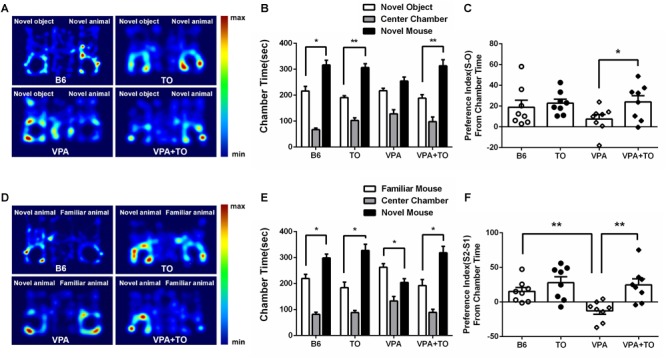
TO pretreatment improved sociability and novel recognition of VPA-exposed mice. (A) Representative heat maps indicate the time distribution of the experimental mice in the sociability test. Warmer colors (red) represent longer stay. (B) VPA-exposed mice had less interest in the chamber with a novel mouse than did the B6 mice. TO pretreatment greatly alleviated the social deficits of the VPA-exposed mice (paired t-test: p < 0.01). (C) VPA-exposed mice showed a relatively lower preference index (S-O/total) than the B6 mice. TO pretreatment had a clear effect on the improvement of social deficits [two-way ANOVA: TO effect: F(1,28) = 3.579, p = 0.069; VPA effect: F(1,28) = 0.888, p > 0.05; TO × VPA effect: F(1,28) = 1.347, p > 0.05, followed by LSD post hoc test]. (D) Representative heat maps indicate the time distribution of the experimental mice in the novel recognition test. (E) VPA-exposed mice spent more time in the chamber with the familiar mouse (S2) than with the novel mouse (S1) (paired t-test: p < 0.05). Similarly, TO pretreatment reversed the effect of the VPA exposure (paired t-test: p < 0.05). (F) VPA-exposed mice displayed a significantly lower preference index (S2-S1/total) than the controls; however, TO markedly improved it [two-way ANOVA: TO effect: F(1,28) = 11.978, p < 0.01; VPA effect: F(1,28) = 4.690, p < 0.05; TO × VPA effect: F(1,28) = 2.963, p = 0.096, followed by LSD post hoc test]. Data are presented as the mean ± SEM. n = 8. ∗p < 0.05, ∗∗p < 0.01.